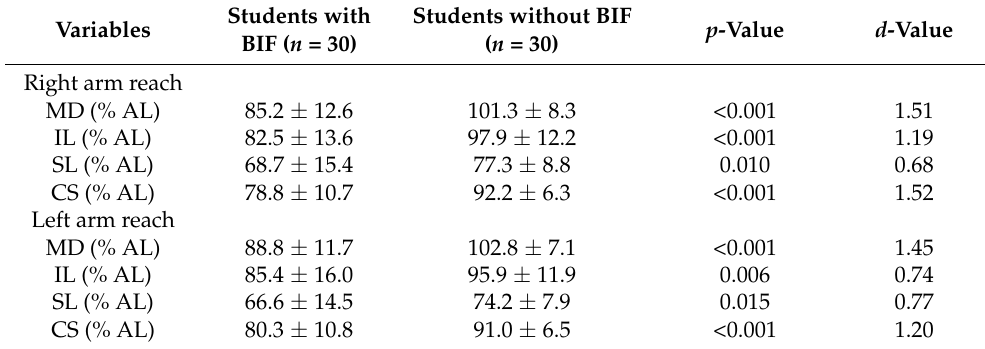
Table 3. Upper Quarter Y Balance Test performance for students with versus without BIF.